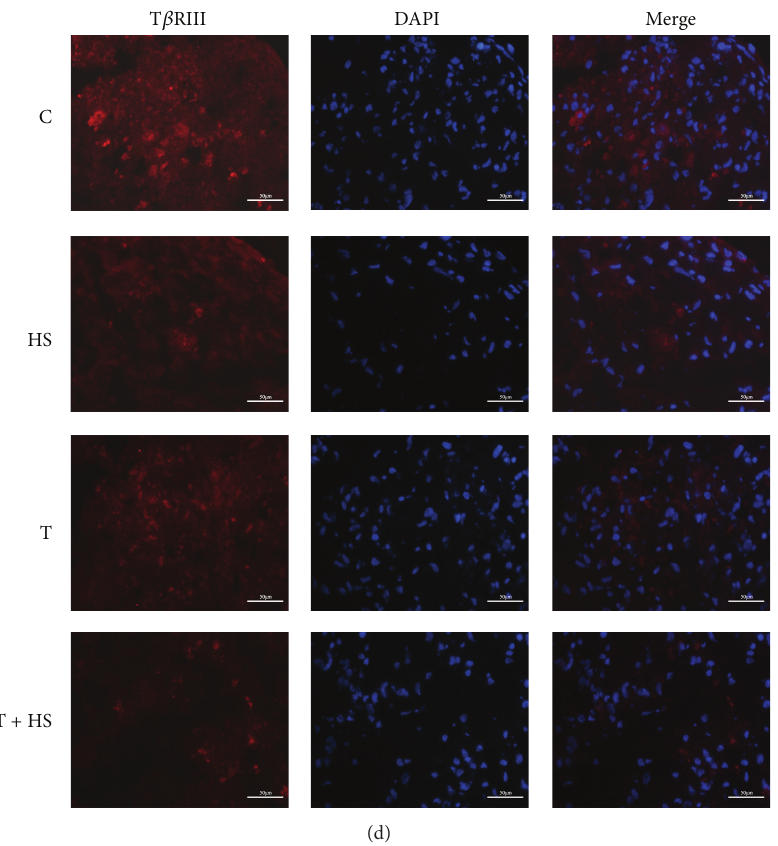
Figure 2: HS modulates expression mode of TGF- 𝛽 receptors. Cells were cultured in four different media (C, HS, T, and T + HS) for 7 days. ( 𝑛 = 3 ) (a) mRNA expression of T 𝛽 RI and T 𝛽 RII and ratio of T 𝛽 RII to T 𝛽 RI by real-time RT-PCR. a 𝑃 < 0.05 versus C group, a versus C group, and b 𝑃 < 0.05 versus T group. (b) The expressions of T 𝛽 RI and T 𝛽 RII are visualized by immunofluorescence staining using anti-T 𝛽 RI (green) and anti-T 𝛽 RII (red) antibodies. Nuclei are counterstained using DAPI (blue). The far right panels show merged images. Scale bar = 50 𝜇 m. (c) mRNA expression of T 𝛽 RIII by real-time RT-PCR assay. a The expressions of T 𝛽 RIII are visualized by immunofluorescence staining using anti-T 𝛽 RIII (red) antibodies. Nuclei are counterstained using DAPI (blue). The far right panels show merged images. Scale bar = 50 𝜇